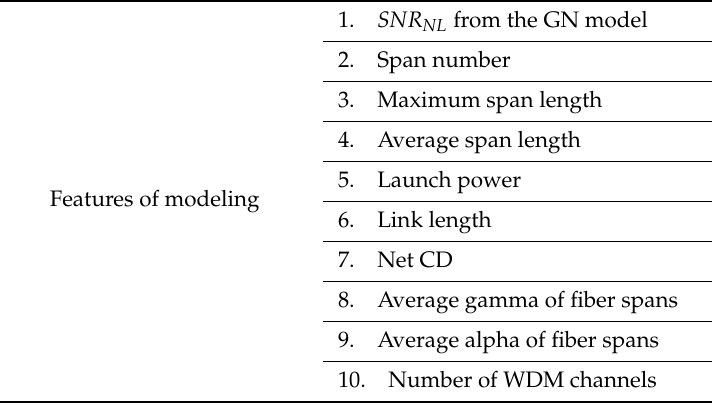
Figure 2. ( a ) The structure of the proposed modeling scheme in [5]. ( b ) The comparison of cumulative distribution functions (CDF) [5]. SNR SSFM means the nonlinear SNR estimated by the SSFM. SNR EST NL means the estimation made by the model proposed in [5]. ∆ SNR means the estimation error between the SNR EST and the SNR SSFM . ( c ) The simulation setup. Table 5. Summary of the modeling input features used in [5].